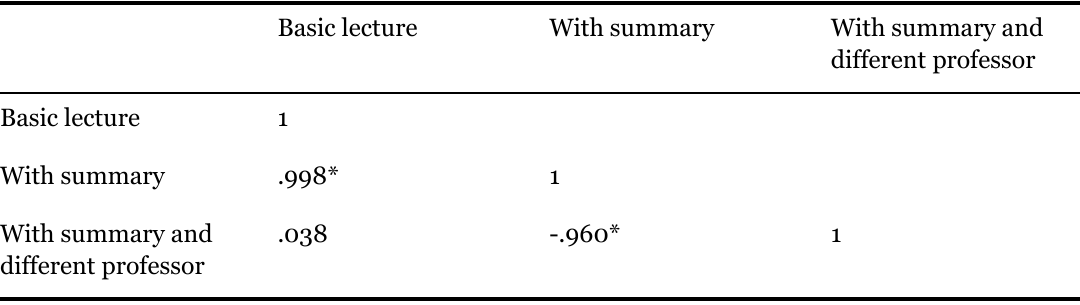
Scheffe Test for Comparisons of the Three Experimental